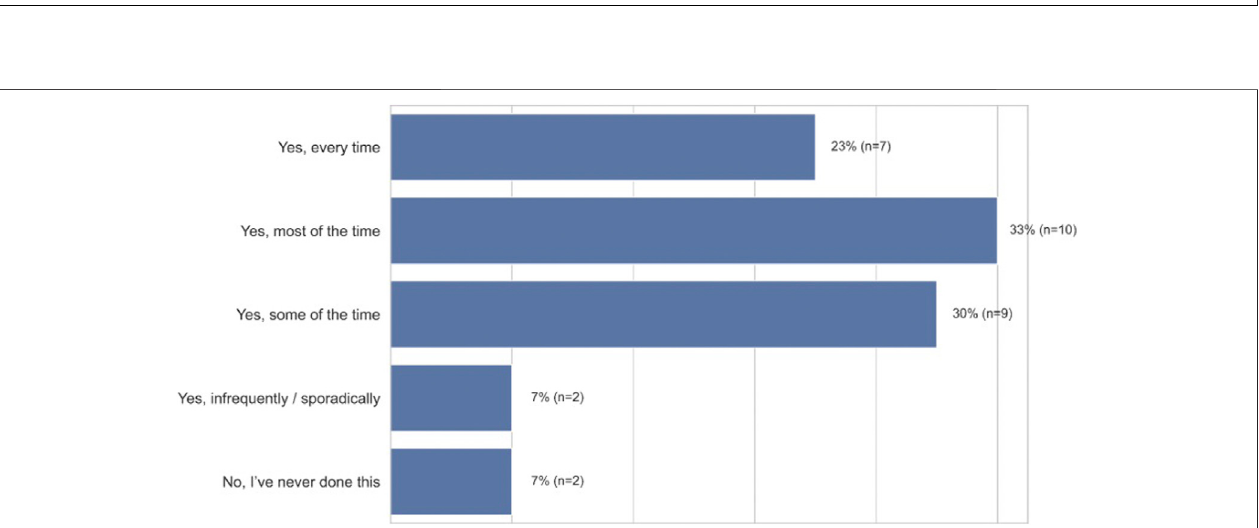
FIGURE 8 | Frequency of speech modi fi cation by African-American participants when using ASR technology ( n (cid:1) 30).